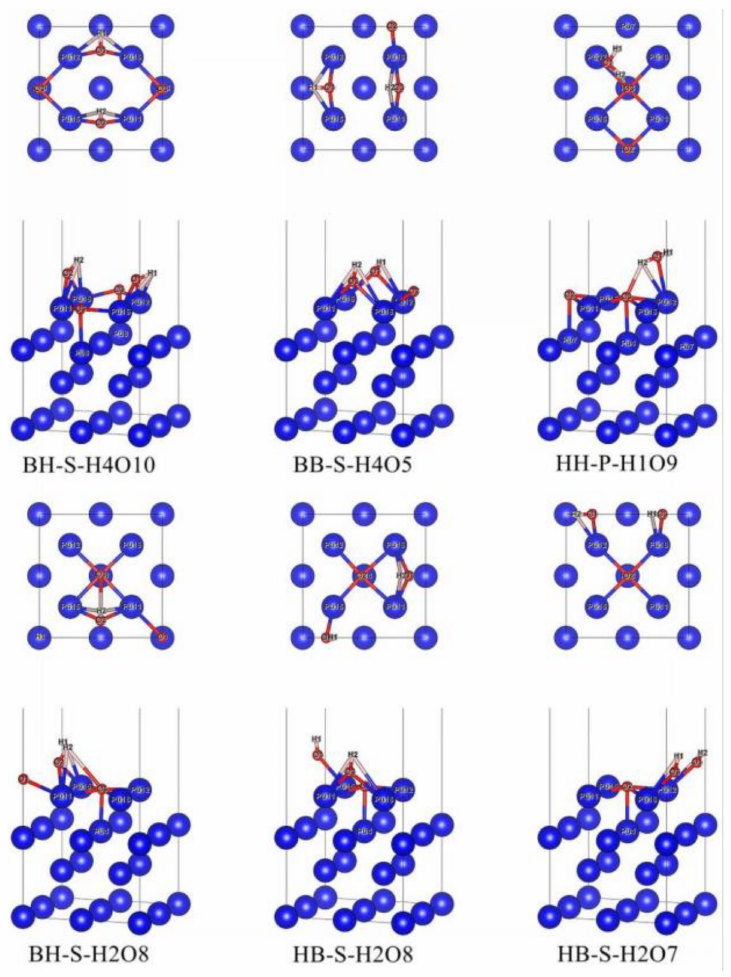
Figure 4. Stable co-adsorption configuration based on the most stable adsorption configuration of H 2 O single